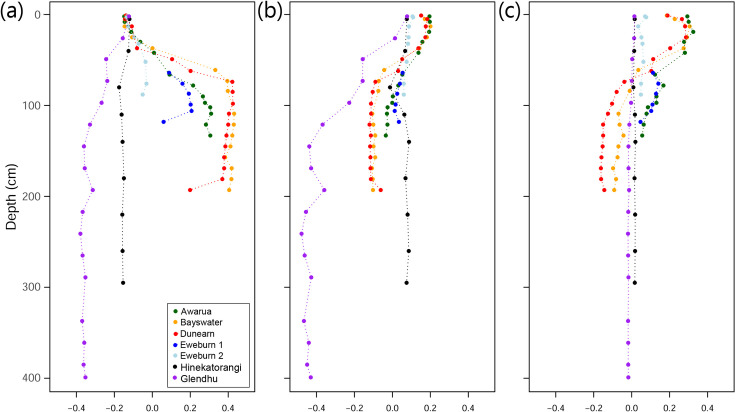
Bray-Curtis PCA (total prokaryote community composition) scores plotted against depth.a) axis 1 (15.14% variation explained); b) axis 2 (8.77% variation explained); c) axis 3 (6.48% variation explained).